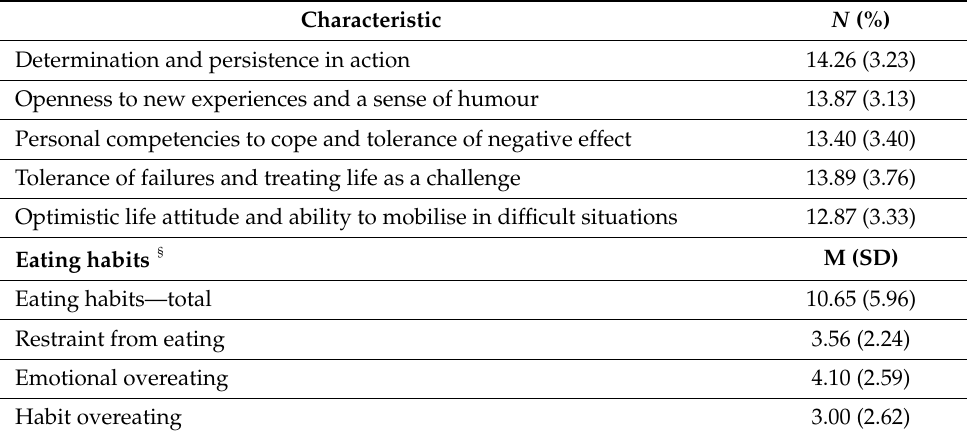
Table 2. Characteristics of the studied group of nurses, including psychophysical wellbeing and sociodemographic features.